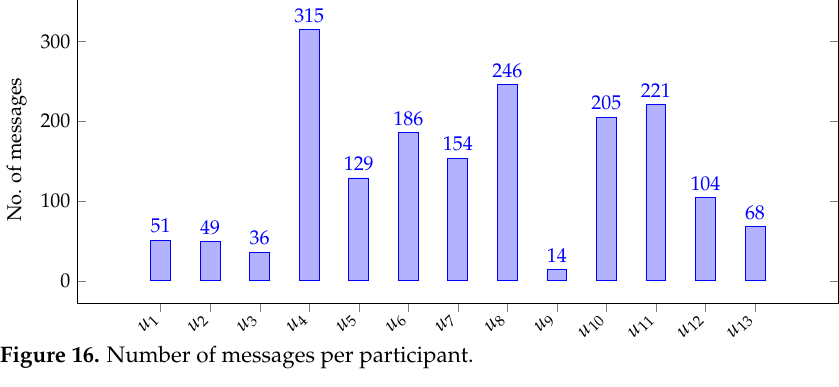
Figure 16. Number of messages per participant.